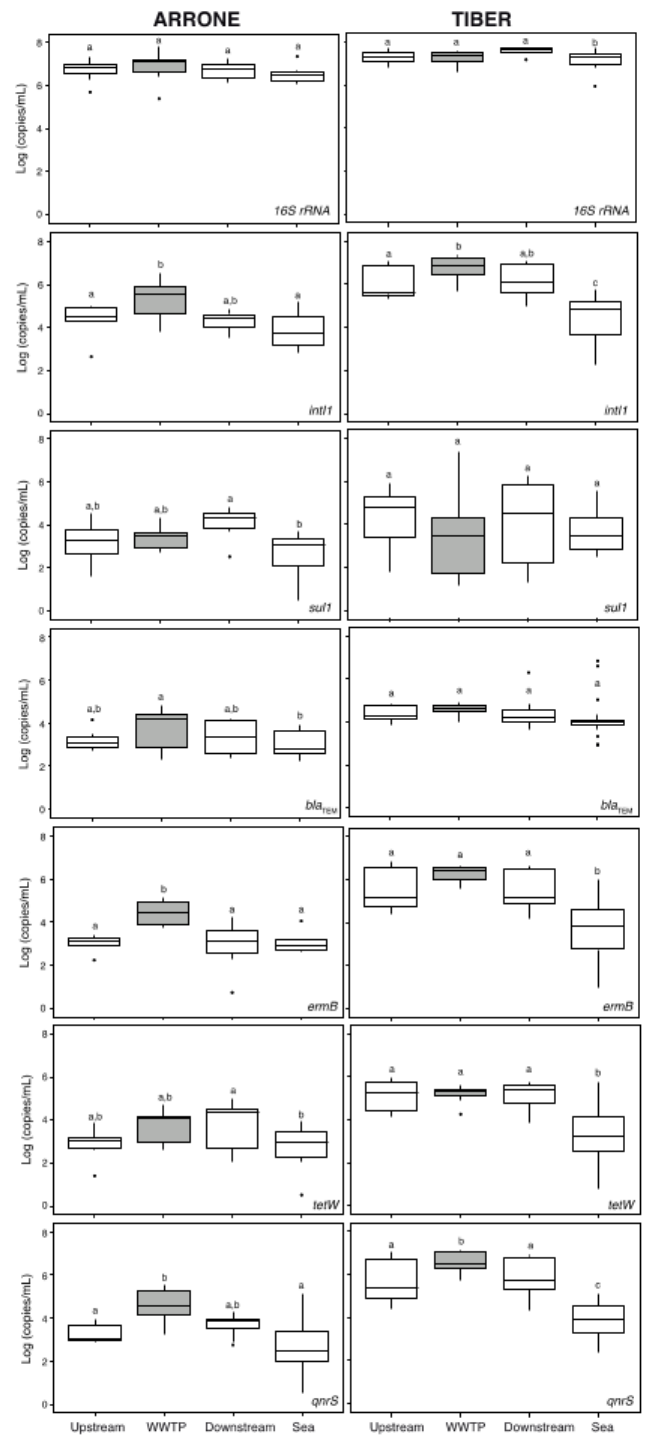
Figure 2. Absolute abundance of target genes in sampled sites from Arrone (left) and Tiber (right) rivers. Di ff erent letters above boxplots indicate significant di ff erences (two-way ANOVA and post hoc Tukey test after correction of p -values for multiple comparisons). The lower and upper edges of each boxplot are the first and third quartiles, the midline shows the median and the whiskers extend from the minimal to the maximal values. Outliers are indicated by black dots. WWTP e ffl uent sample is highlighted in